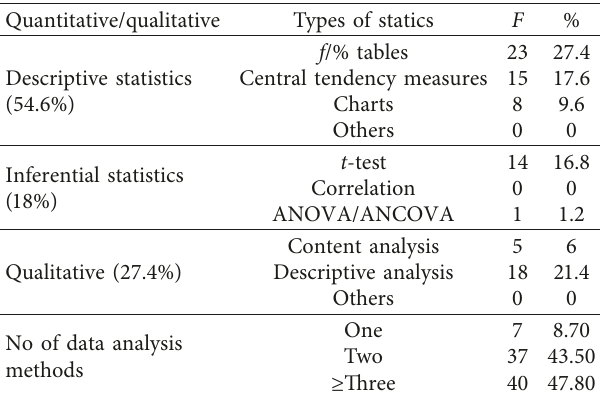
Figure 3: Frequently studied sample sizes in IBL studies in Ethiopia (2010 to 2021). Table 9: Frequently used data analysis methods in IBL studies in Ethiopia (2010 to